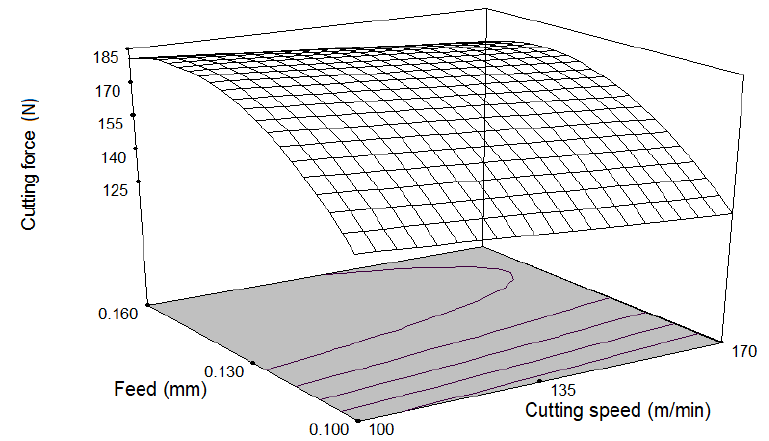
Figure 3. Response surface graph of 3D surface for F.